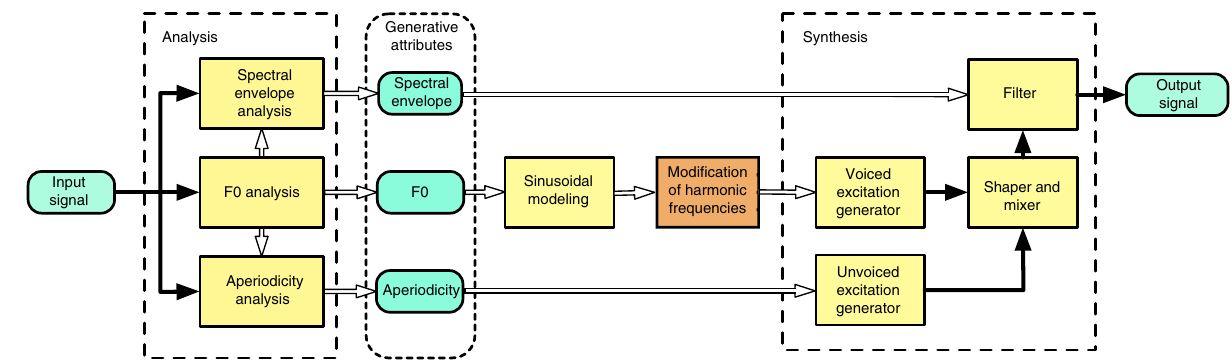
Fig. 1 Schematic of STRAIGHT with sinusoidal modeling. An input signal is decomposed into a time-varying spectral envelope and time-varying periodic and aperiodic excitation. The periodic excitation is modeled as a sum of sinusoids, the frequencies of which can be altered and combined with the aperiodic (unvoiced) excitation and then fi ltered to impose the original spectrotemporal envelope, yielding inharmonic